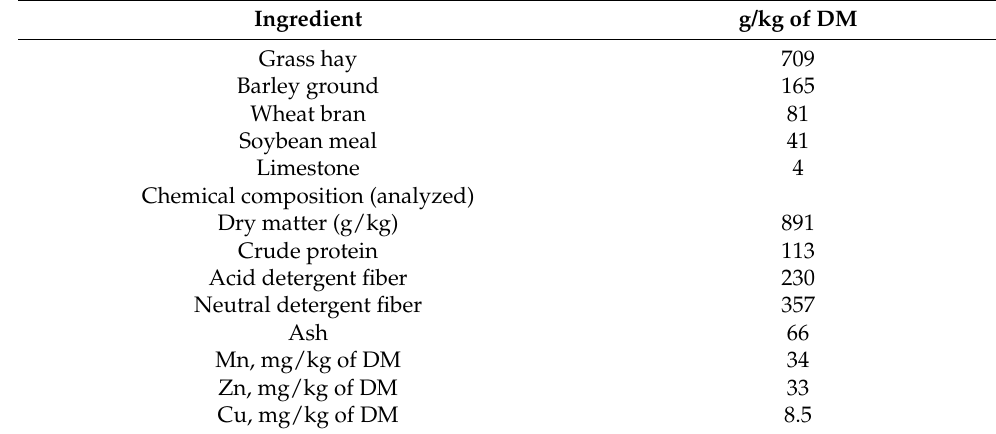
Table 1. Ingredients and chemical composition of the total mix ration (TMR) 1 on a dry matter (DM)